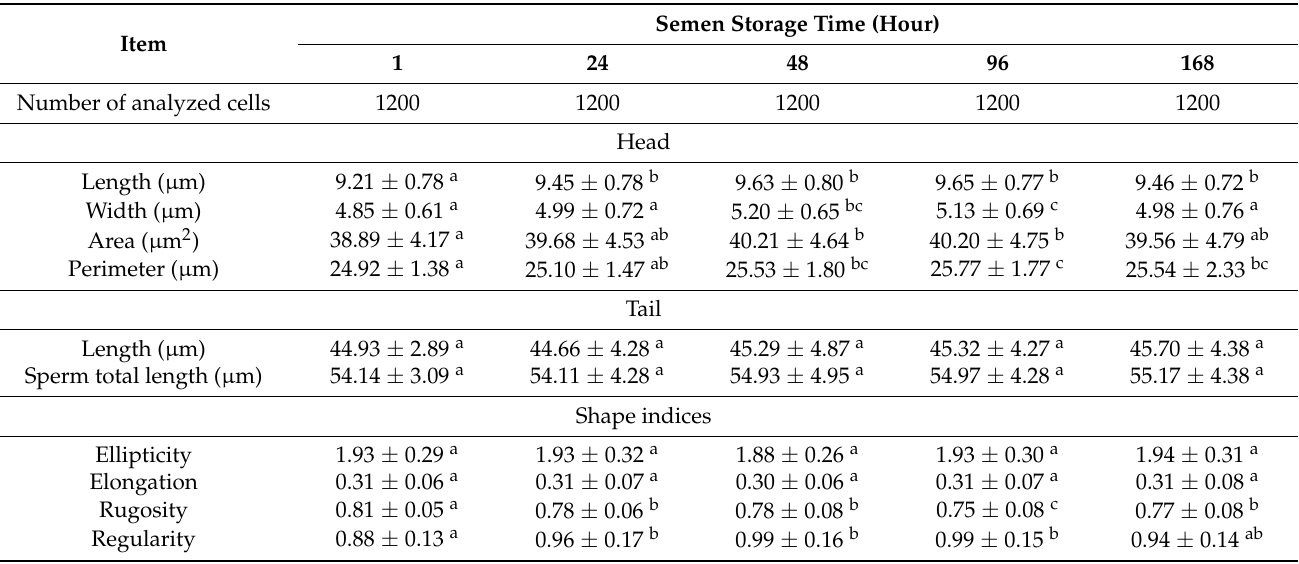
Table 2. Morphometric dimensions of sperm stained by the eosin-gentian method in semen stored at 17 ◦ C (mean ± SD).